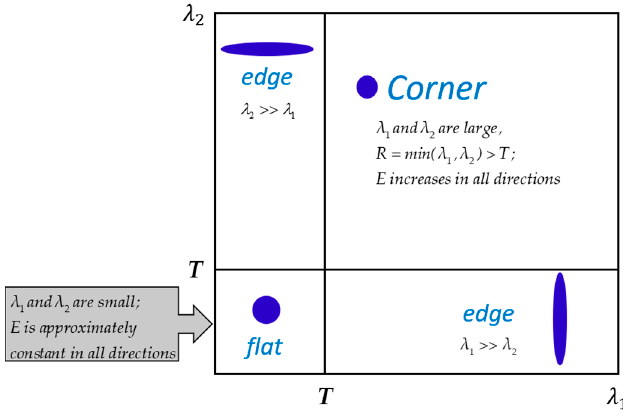
Figure 4. Schematic of the Shi_Tomasi algorithm.